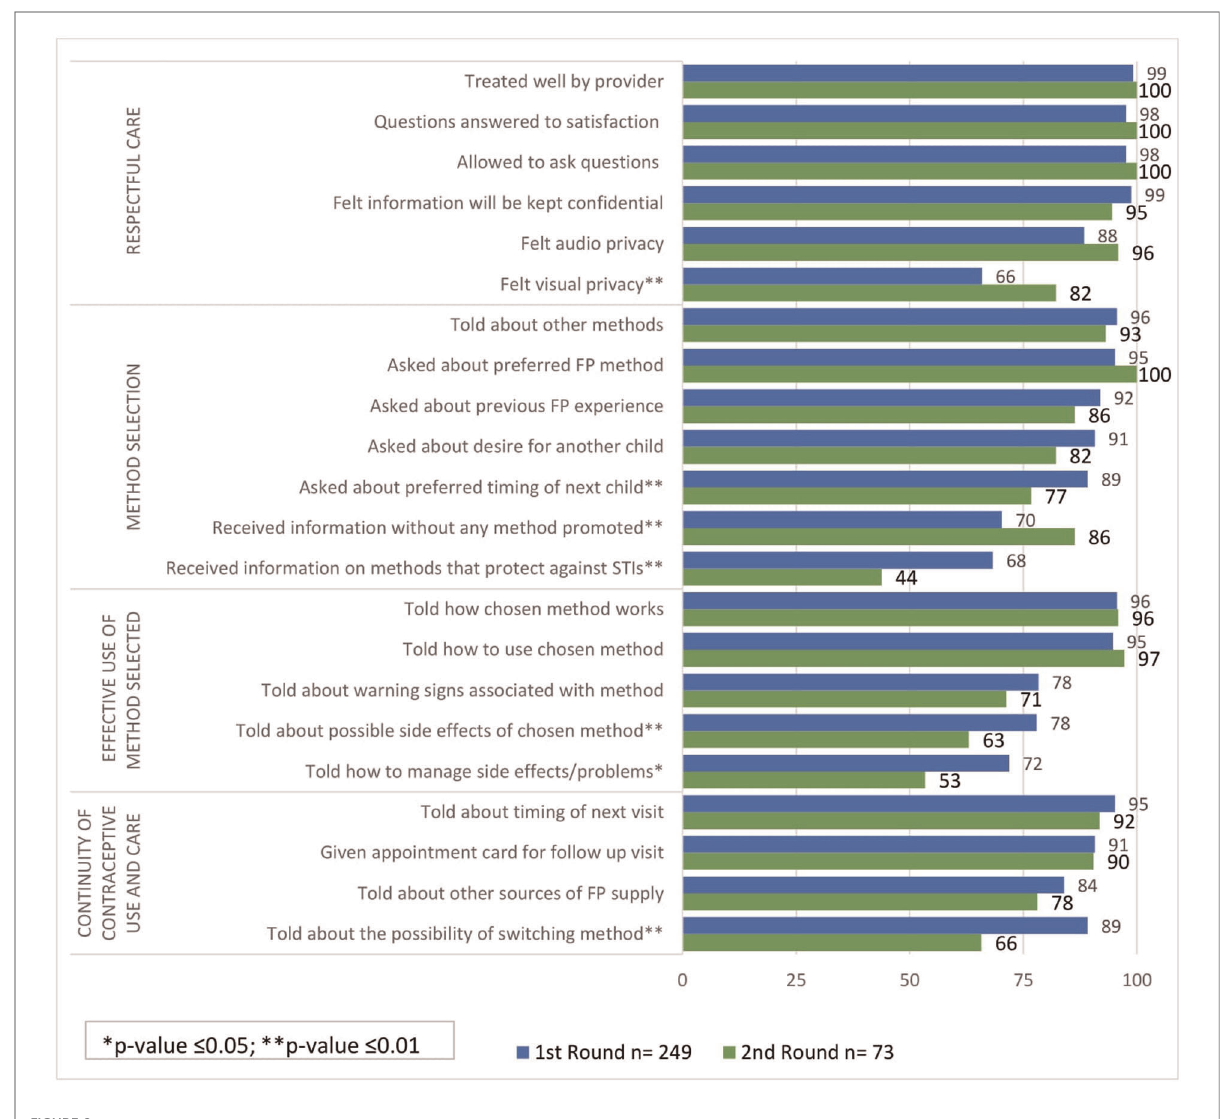
FIGURE 2 Percentage of women reporting quality of care received from CPs and PPMVs in Kaduna by domain and round ( n